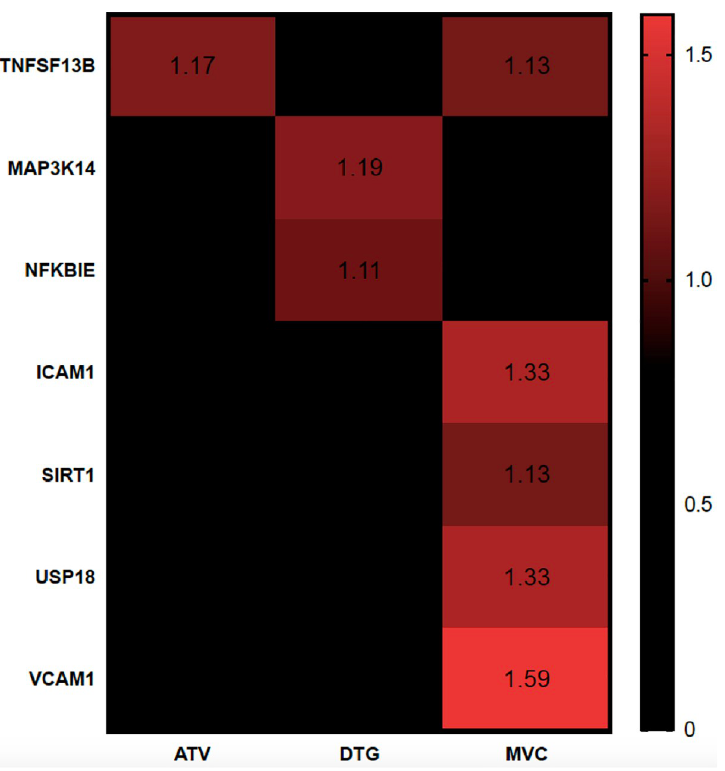
Fig 3. Heatmap representing identified genes of interest which level was affected by antiretrovirals. Values are presented as follows: fold change in gene expression upregulated vs control (red). Black cases represent non- significative variation of genes vs control. TNFSF13B: tumor necrosis factor ligand superfamily member 13 or B-cell activating factor (BAFF); MAP3K14: mitogen activated protein kinase kinase kinase 14; NFKBIE: NF κ B inhibitor